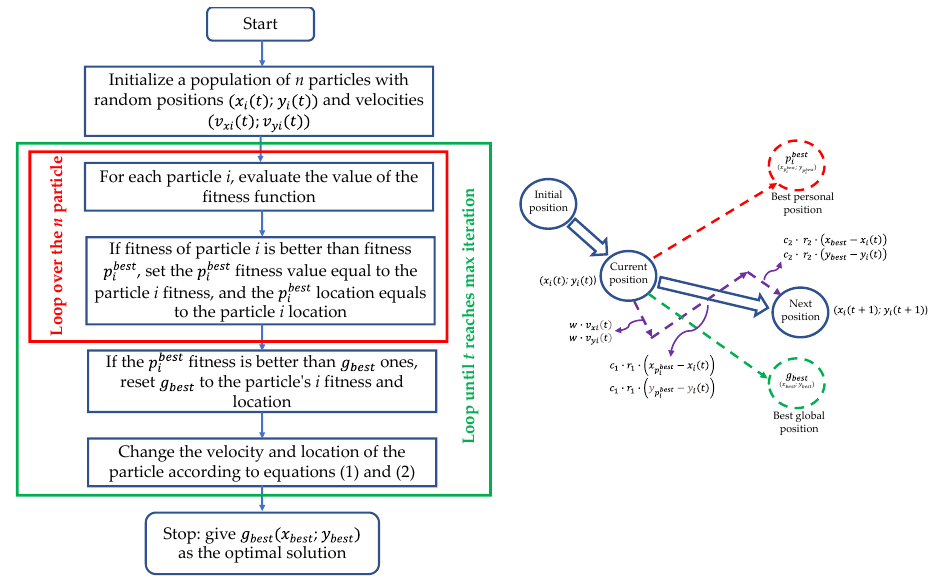
Figure 2. Flow-chart of the PSO algorithm and the principle of the PSO particle movement.